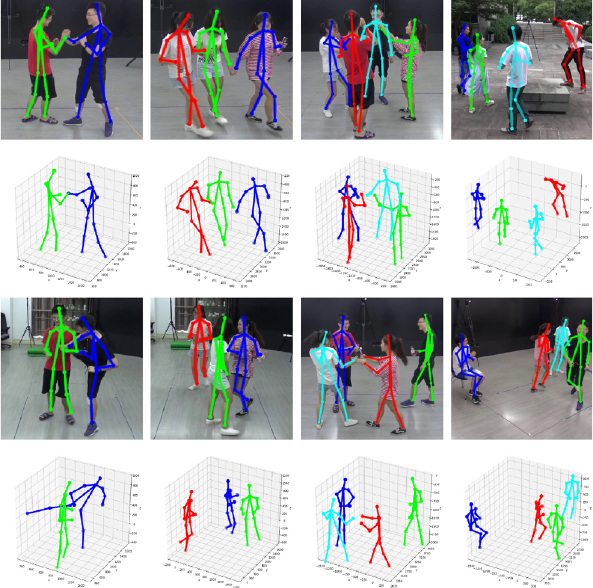
Fig. 1 Indoor and outdoor examples captured using our